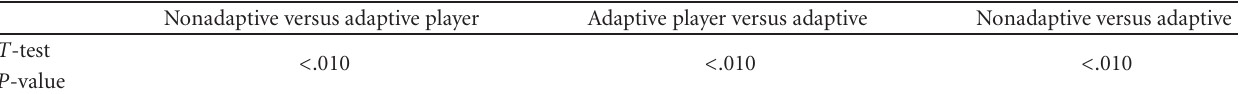
Table 1: E ff ectiveness test results for the fundamental TAP experiments: Table of t -test P -values.